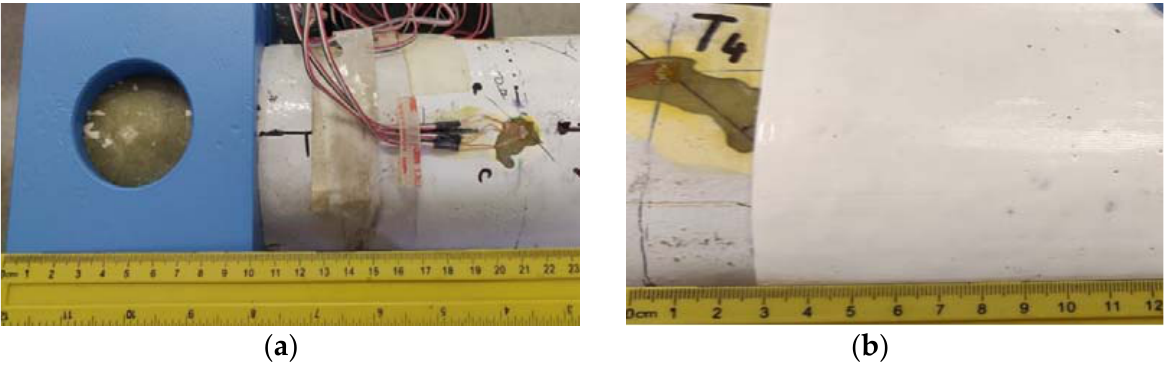
Figure 10. Measuring section located 230 mm from grip end ( a ) and 130 mm from blade tip ( b ).